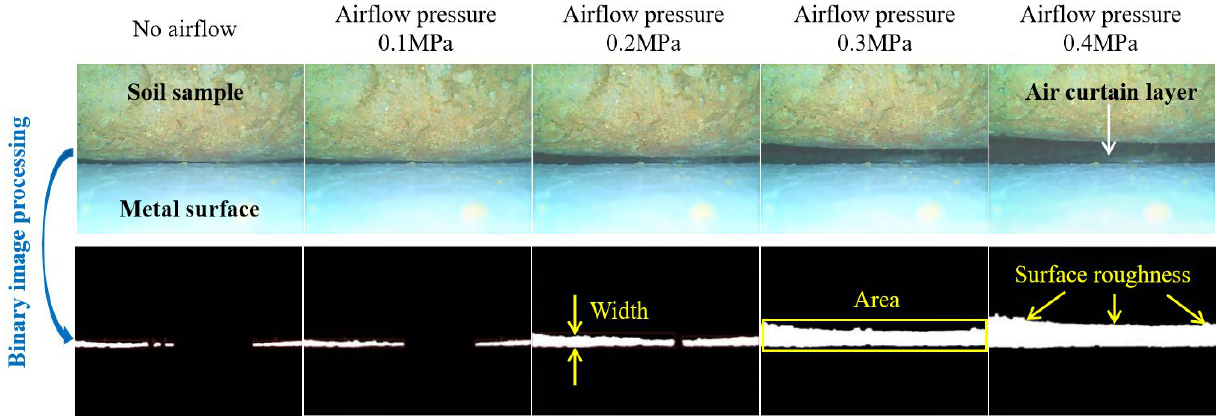
Figure 7. Microscopic images of the air curtain layer at different airflow pressures.